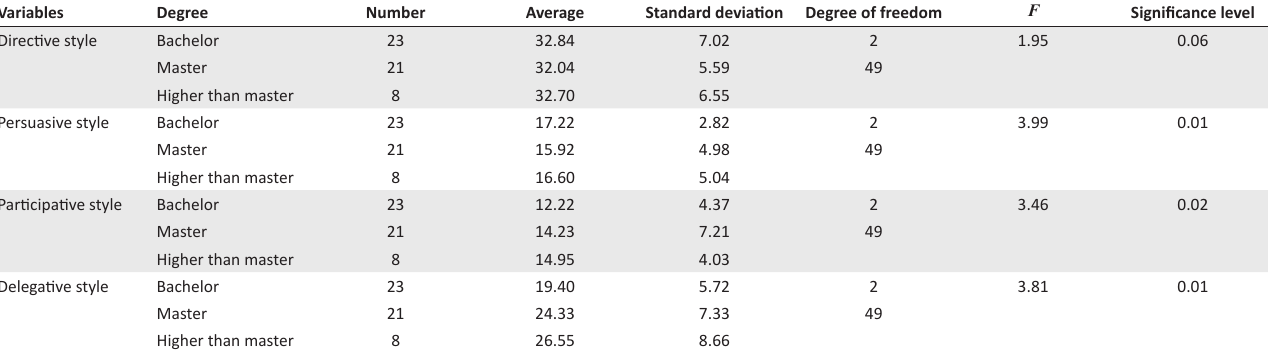
TABLE 3: Results of the one-way analysis of variance of the thinking styles, with respect to the managers’ education level. Variables Degree Number